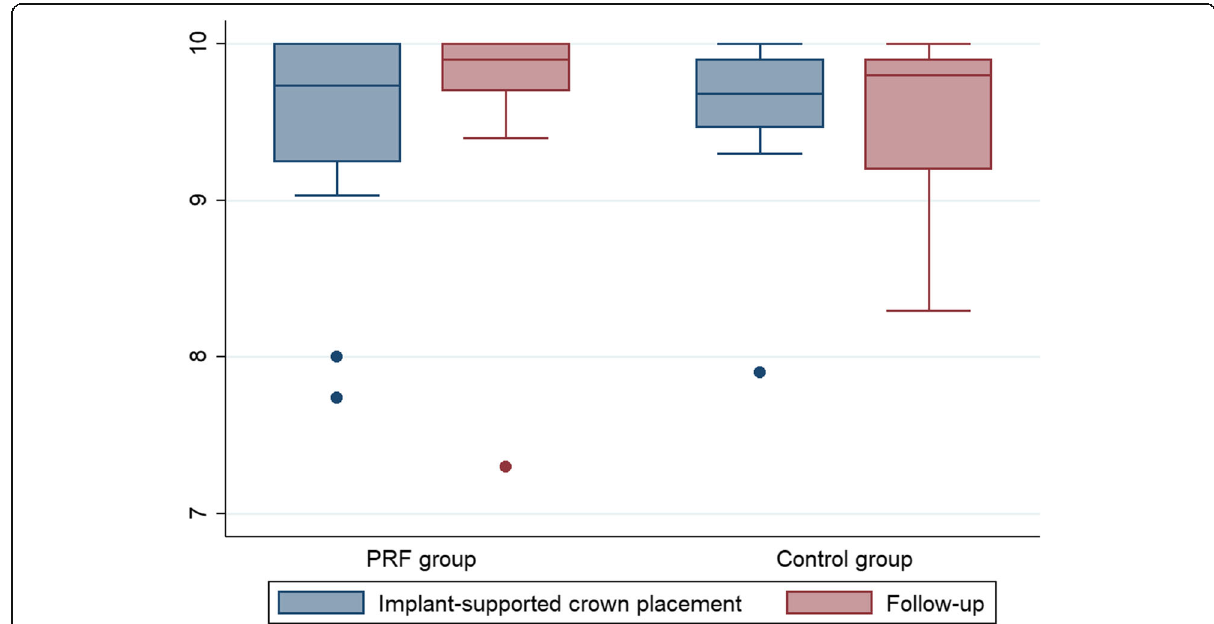
Fig. 3 Data from the VAS of patient-related outcome measures at the time of mounting of the implant-supported crown and at the final follow- up of the PRF and control